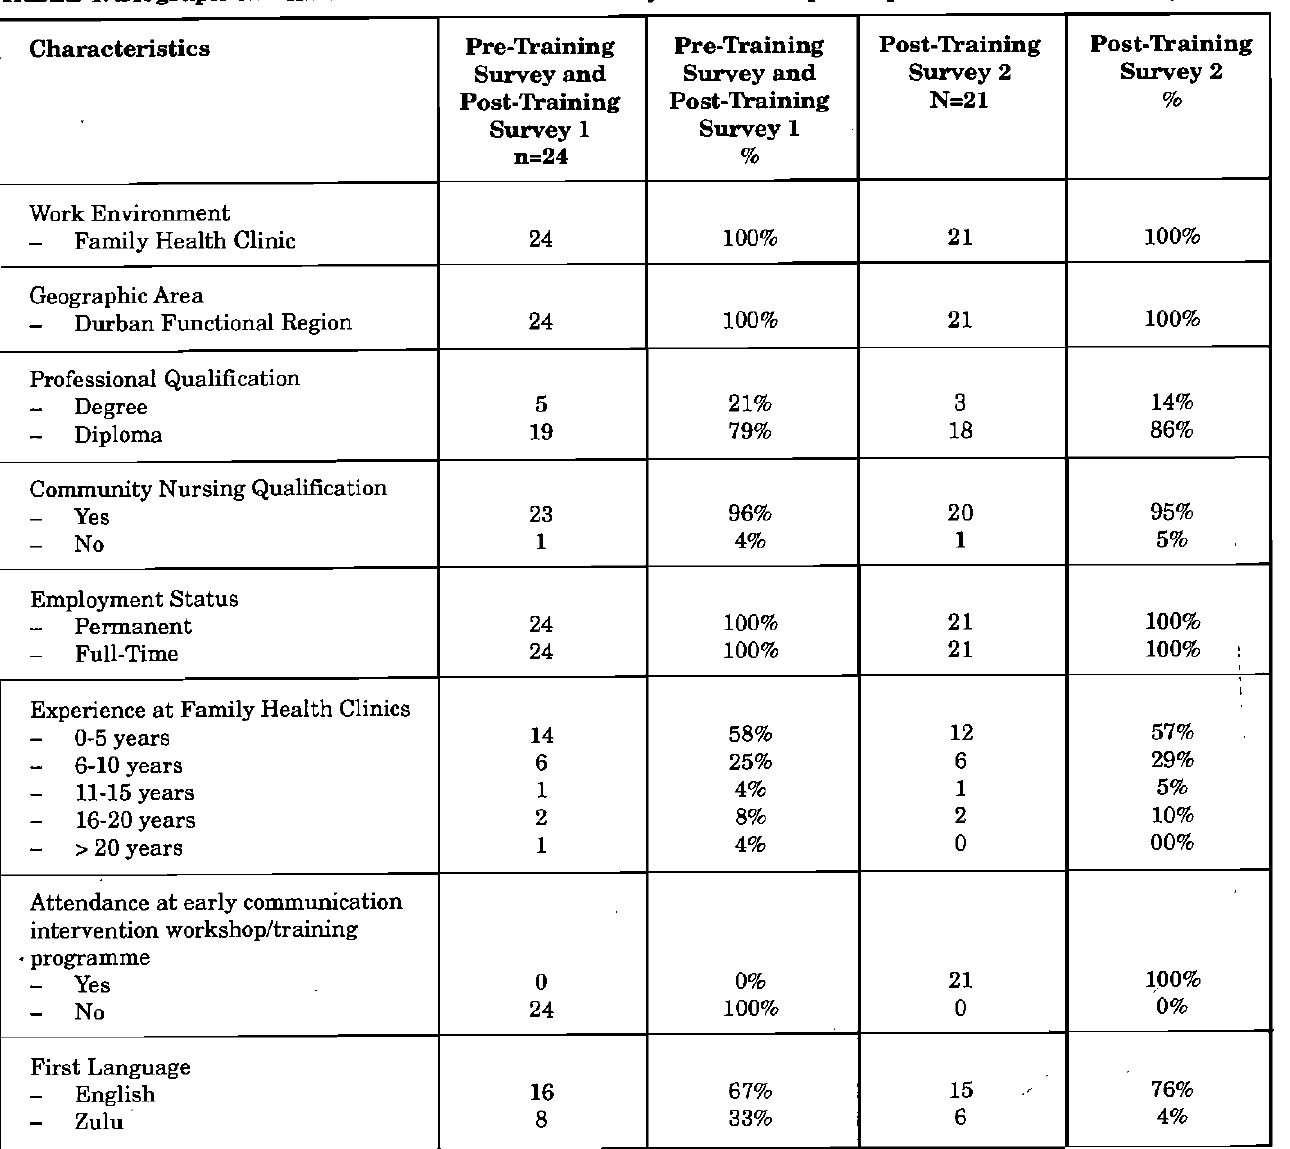
TABLE 1: Biographical characteristics of the community nurses who participated in the three surveys